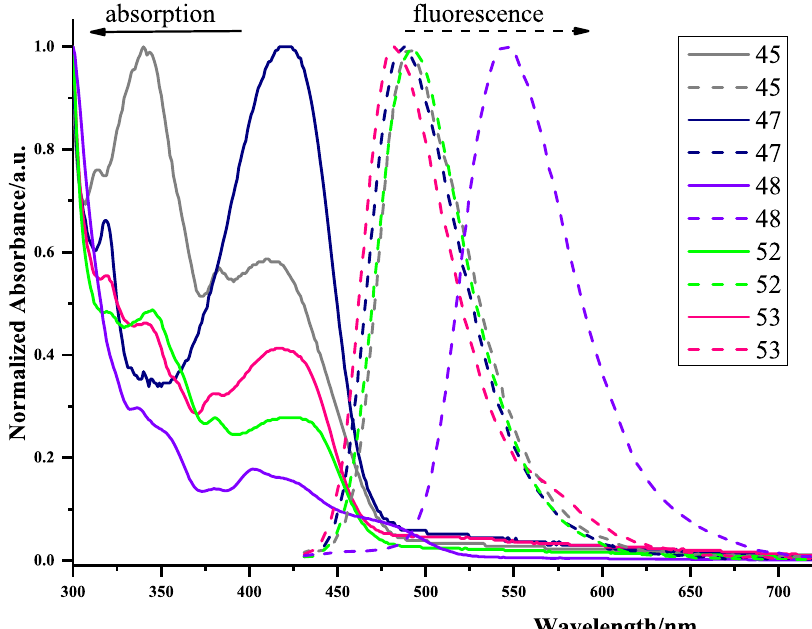
Fig. 5 The UV/Vis absorption (solid lines) and emission spectra (broken lines) in DMSO. The extension of π -conjugated system to enlarge the maximum emission of